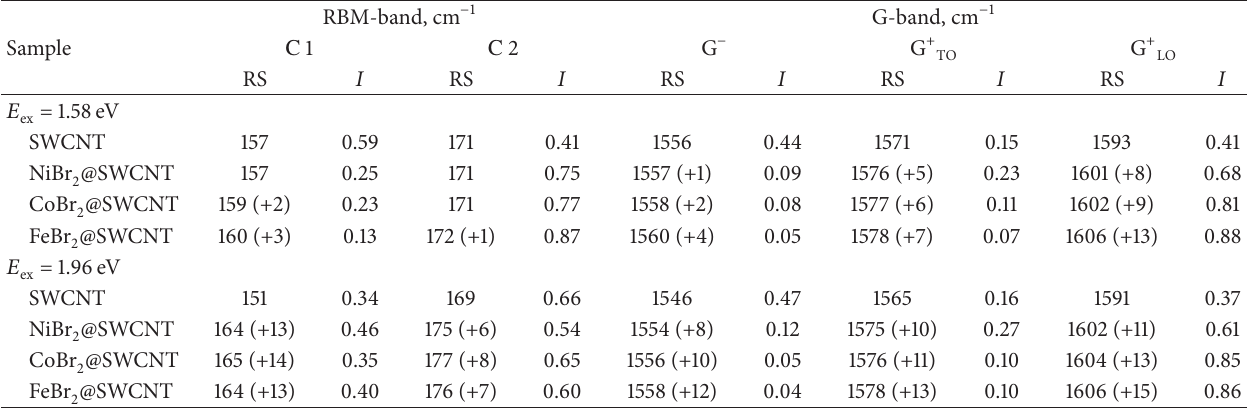
Table 1: The positions (RS) and relative intensities ( 𝐼 ) of the components of the RBM-bands (C 1 and C 2) and G-bands (metallic G − and and G + ) of the Raman spectra of the pristine SWCNTs, NiBr semiconducting G + TO LO samples, acquired at laser energies of 1.58 eV and 1.96 eV. In the parentheses the shifts of the component positions in comparison to ones of the pristine SWCNTs are given. The experimental error in the component positions equals ± 0.5 cm − 1